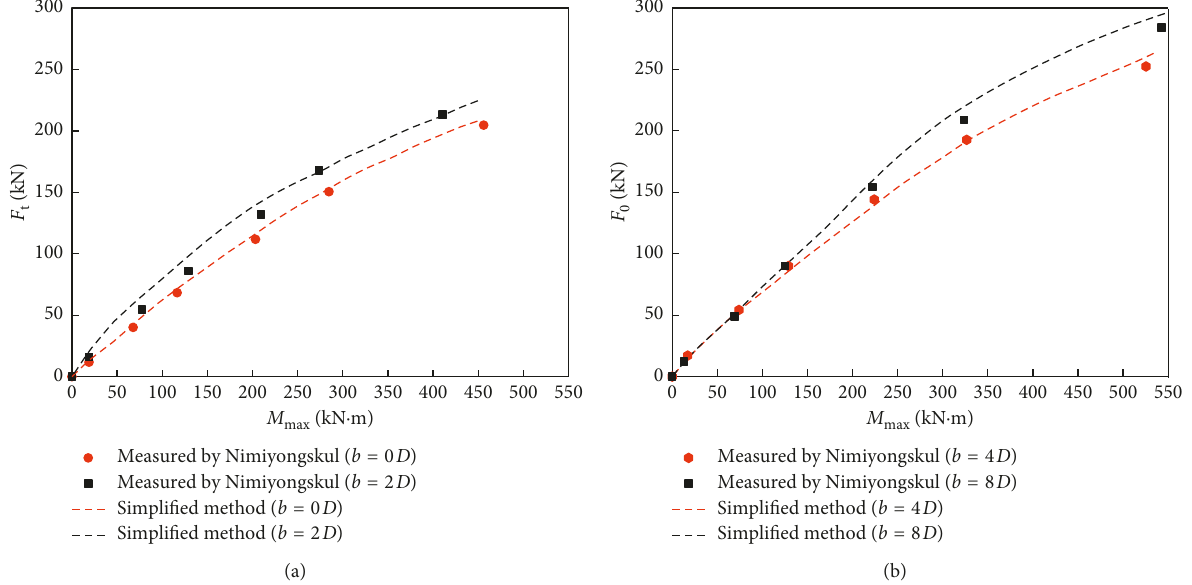
Figure 6: Comparison of lateral load ( F 0 ) versus maximum bending moment ( M max ) curves for different near-slope distances: (a) b and 2 D ; (b) b � 4 D and 8 D .